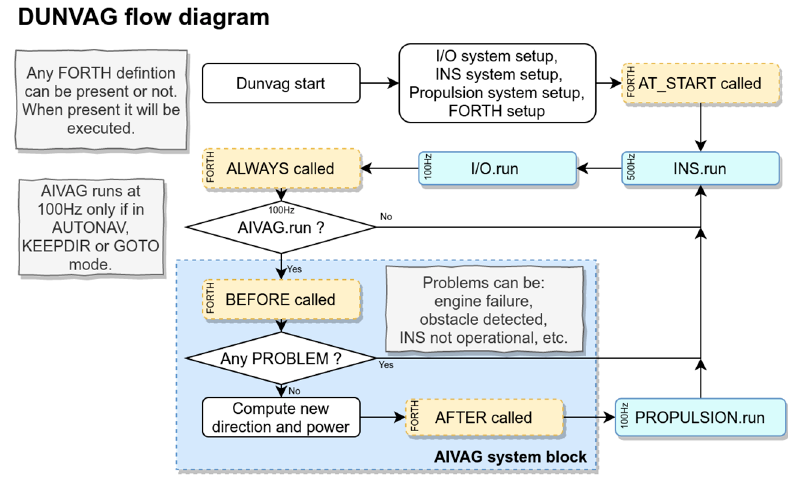
Figure 6. Block model of DUNVAG , the hearth of the system which implement autonomous navigation algorithms.